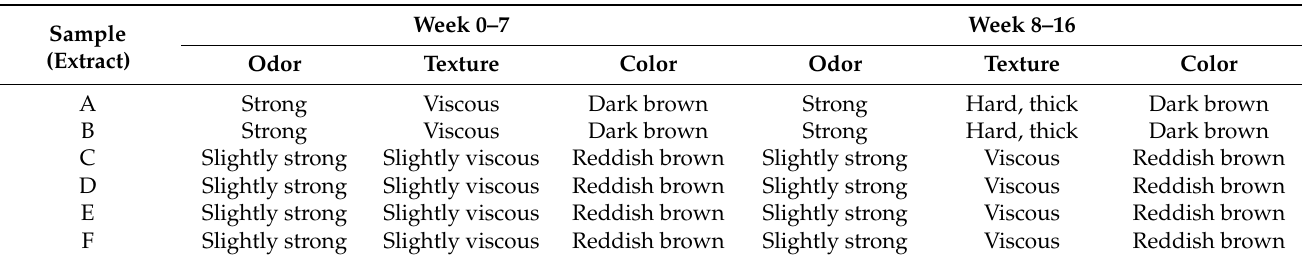
Table 5. Organoleptic test of all stability test samples. The details of sample (extract) code refer to Table